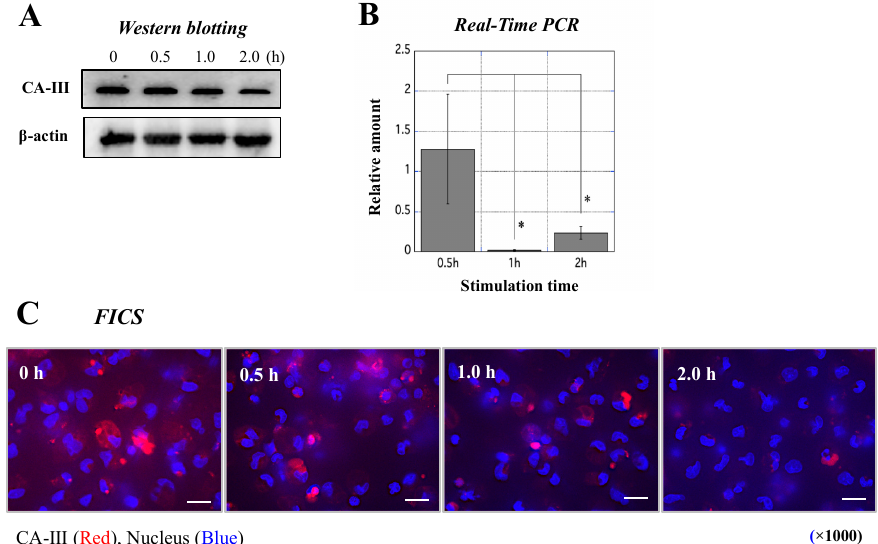
Figure 7. Measurement of CA-III expression in rat M Φ stimulated with LPS by western blotting, real-time PCR, and immunofluorescence. ( A ) Western blotting was performed to detect CA-III in M Φ stimulated with LPS (Figure S4). The upper and lower panels show CA-III and β -actin (internal control) expression, respectively, in M Φ stimulated with LPS for 0, 0.5, 1, and 2 h. ( B) Real-time PCR was conducted to analyze the relative amount of mRNA in M Φ stimulated with LPS. The X-axis indicates the stimulation time (0.5, 1, and 2 h), while the Y-axis shows the relative amount of CA-III in stimulated M Φ relative to CA-III in unstimulated M Φ . Data are the mean ± SD. * p < 0.05. ( C ) Microscopic observations of CA-III expressed in M Φ stimulated with LPS for 0, 0.5, 1, and 2 h by immunofluorescence. CA-III (red) and nuclei (blue) were stained according to previously published methods [11]. High power magnification images are shown for all panels ( × 1000). White scale bar = 10 µ m. CA-III: carbonic anhydrase III; LPS: lipopolysaccharide; M Φ : peritoneal macrophages; FICS: fluorescent immunochemical staining.